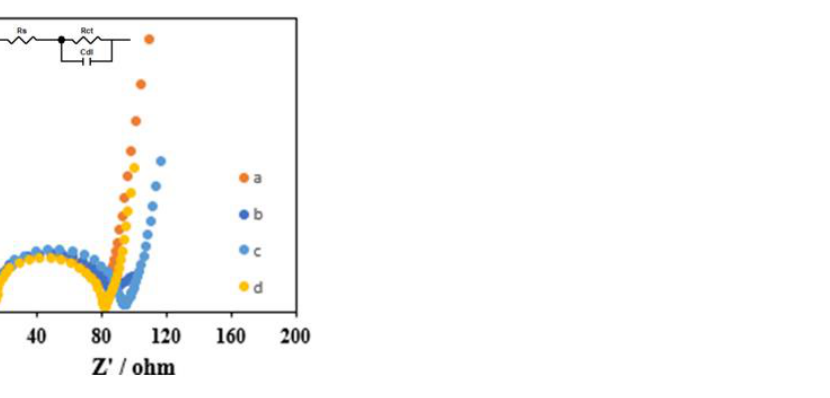
Figure 4. EIS of different modified GCEs: GCE (a), NF/MWCNTs/GCE (b), NF/CMC-MWCNTs/GCE (c), and NF/IL/CMC-MWCNTs/GCE (d), with a frequency range from 10 2 to 10 6 Hz.